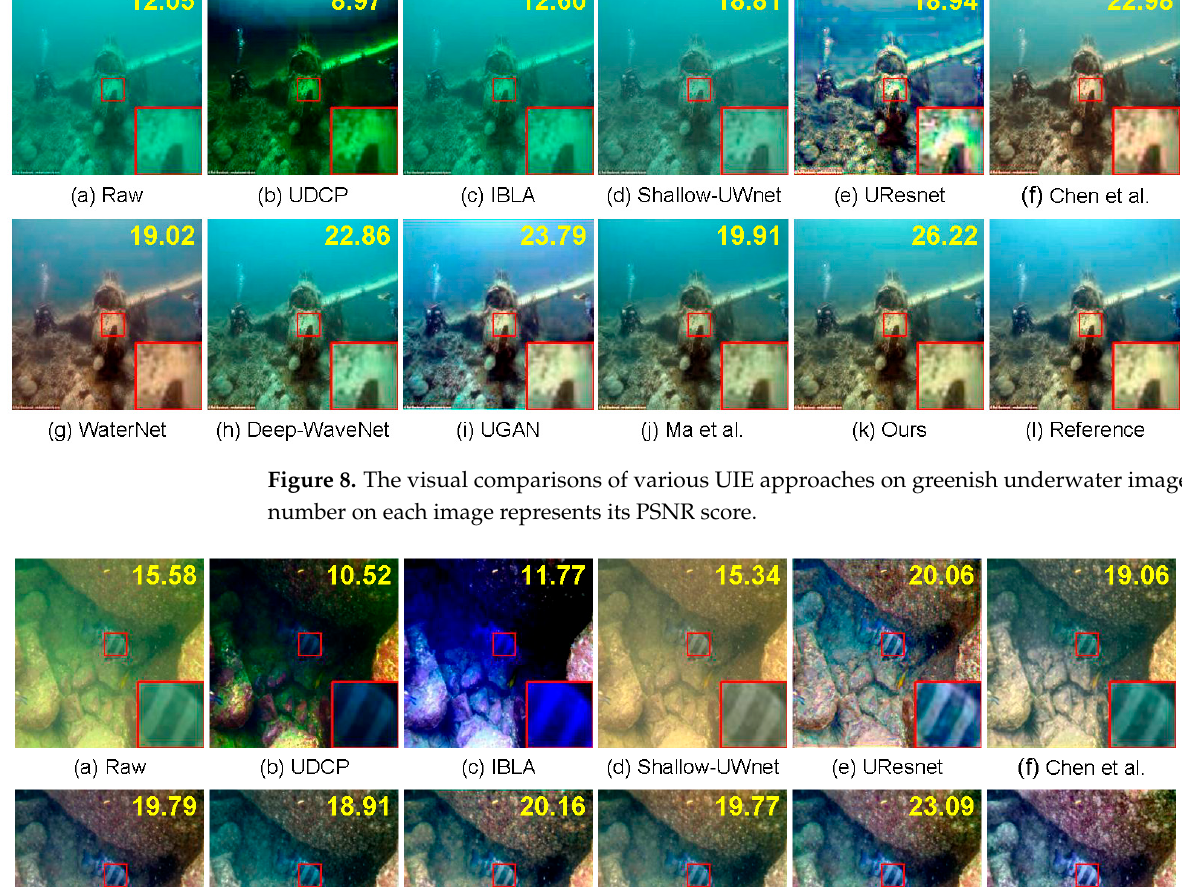
Figure 7. The visual comparisons of various UIE approaches on the bluish underwater images. The number on each image represents its PSNR score.